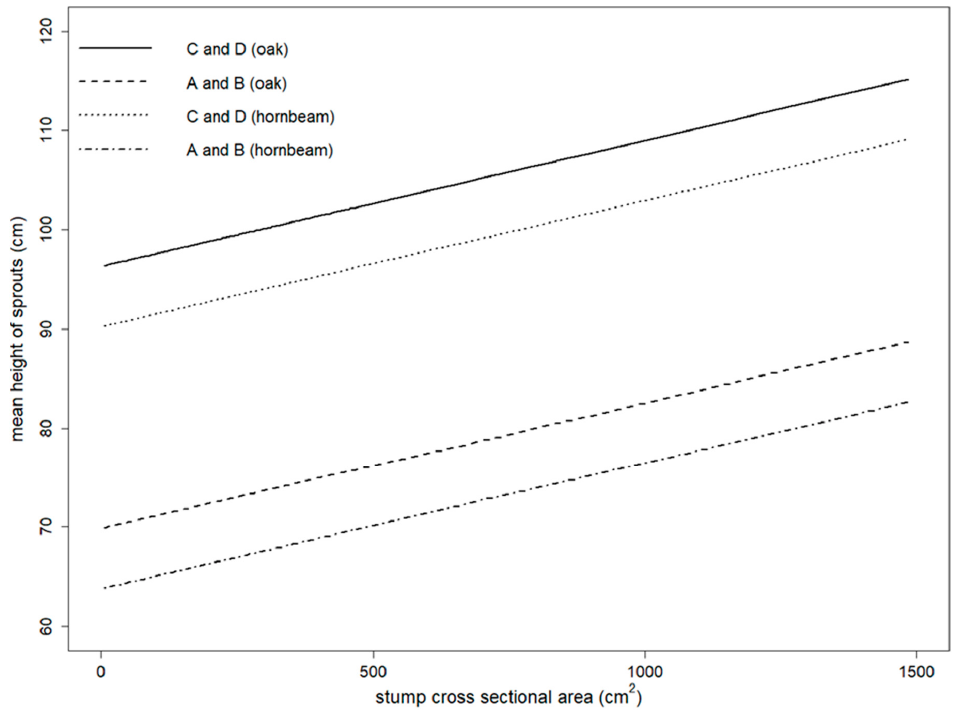
Figure 4. Fitted values of the average sprout height in relation to stump cross sectional area, species, and management type (A: coppice-with-standards + raking + grazing; B: coppice-with-standards + grazing; C: coppice-with-standards + raking; and D: grazing; C: coppice-with-standards + raking; and D: coppice-with-standards).